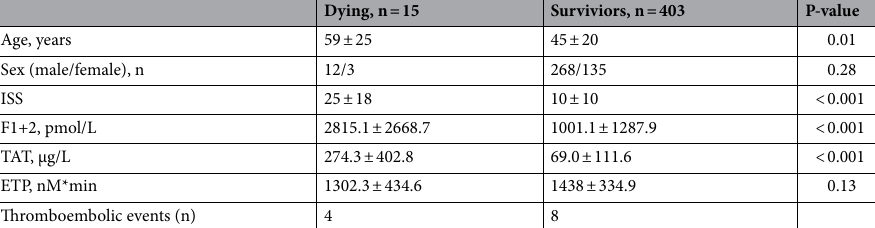
Table 4. Admission charateristics of patients dying/surviving the initial 30 days after trauma. Data presented as mean ± sd unless stated otherwise. Abbreviations: ETP endogenous thrombin potential, F1+2 prothrombin fragment F1+2, ISS Injury Severity Score, TAT Thrombin-antithrombin complex levels.